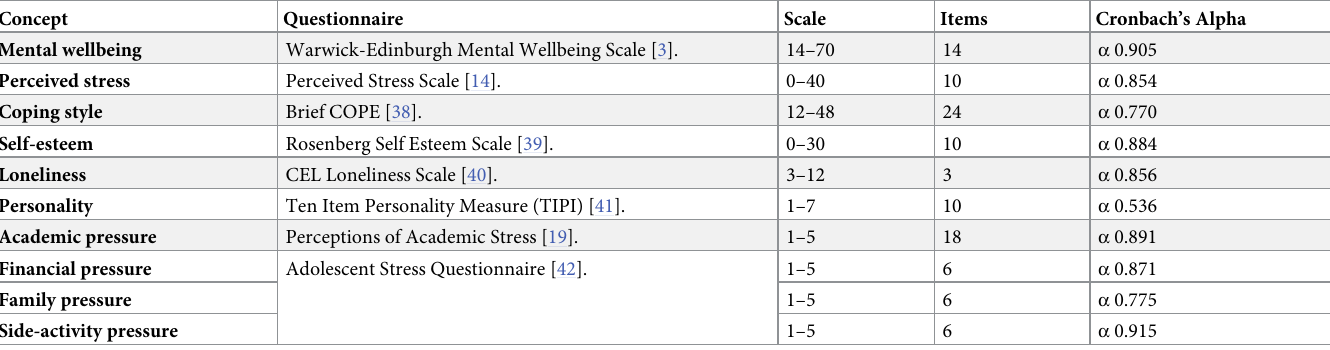
Table 1. Study variables with measures and internal